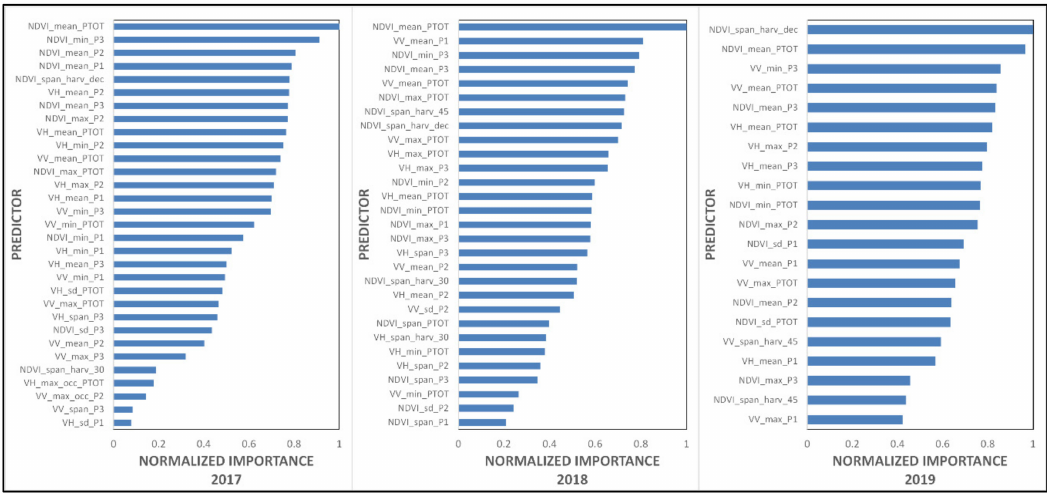
Figure 10. Normalized importance of the predictors selected for 2017, 2018, and 2019